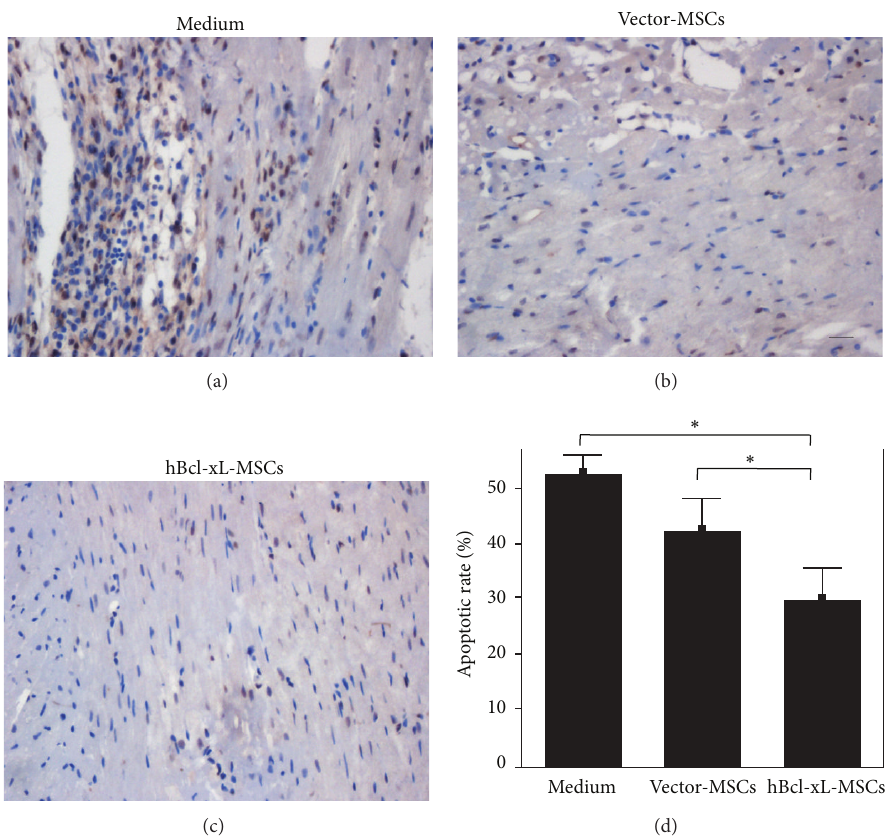
Figure 6: Antiapoptotic effect of hBcl-xL-MSCs in vivo . ((a)–(c)) TUNEL assay was performed at 4 weeks after transplantation of medium (a), vector-MSCs (b), or hBcl-xL-MSCs (c). TUNEL-positive cells were defined as cells with clear brown-colored nuclear labeling. (d) The apoptotic rate was presented as the ratio of the area of TUNEL-positive cell nuclei and the area of total cell nuclei. Values are mean ± SD ( 𝑛 = 6 , ∗ 𝑃 < 0.001 ). TUNEL: terminal deoxynucleotidyl transferase-mediated dUTP end labeling. Scale bar represents 50 𝜇